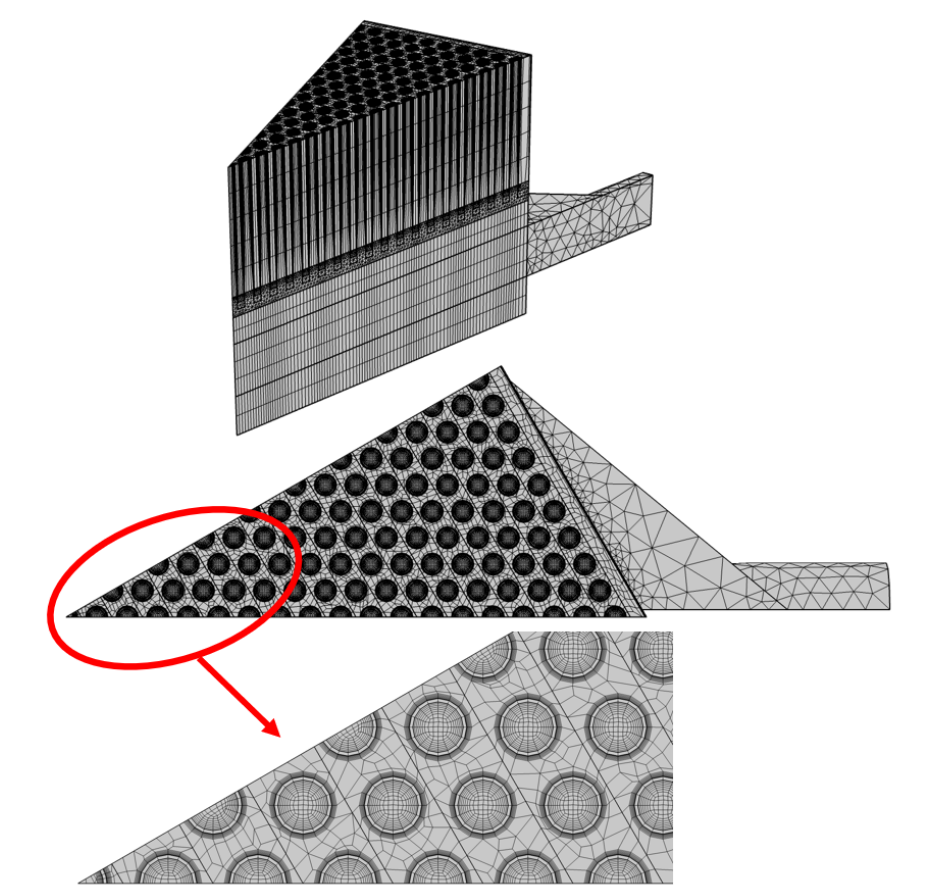
Figure 5. Model with mesh rendering: top, 3D view; middle, top view, xy-plane; bottom, top view zoomed